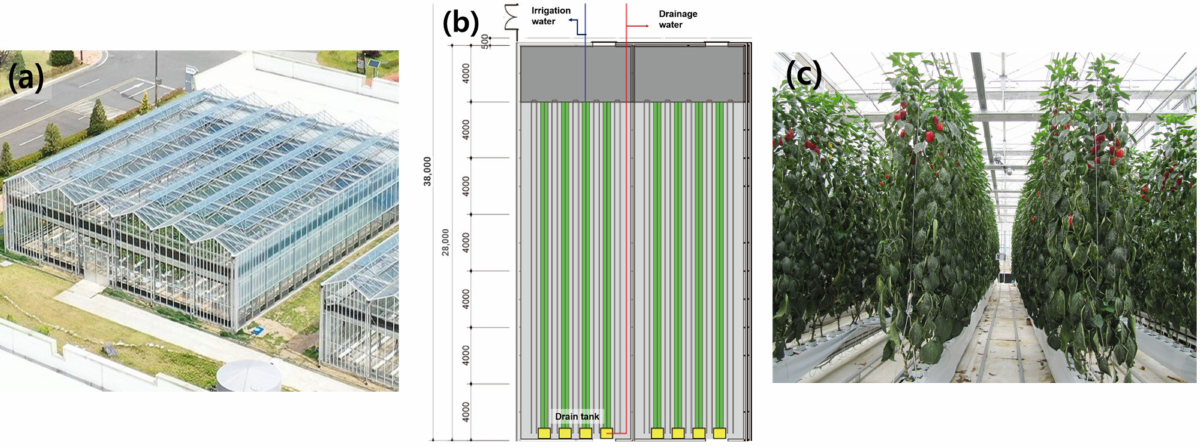
Figure 1. The Venlo-type glasshouse ( a ), its internal details ( b ), and paprika ( Capsicum annum L. var. Cupra) plants ( c ) used in the